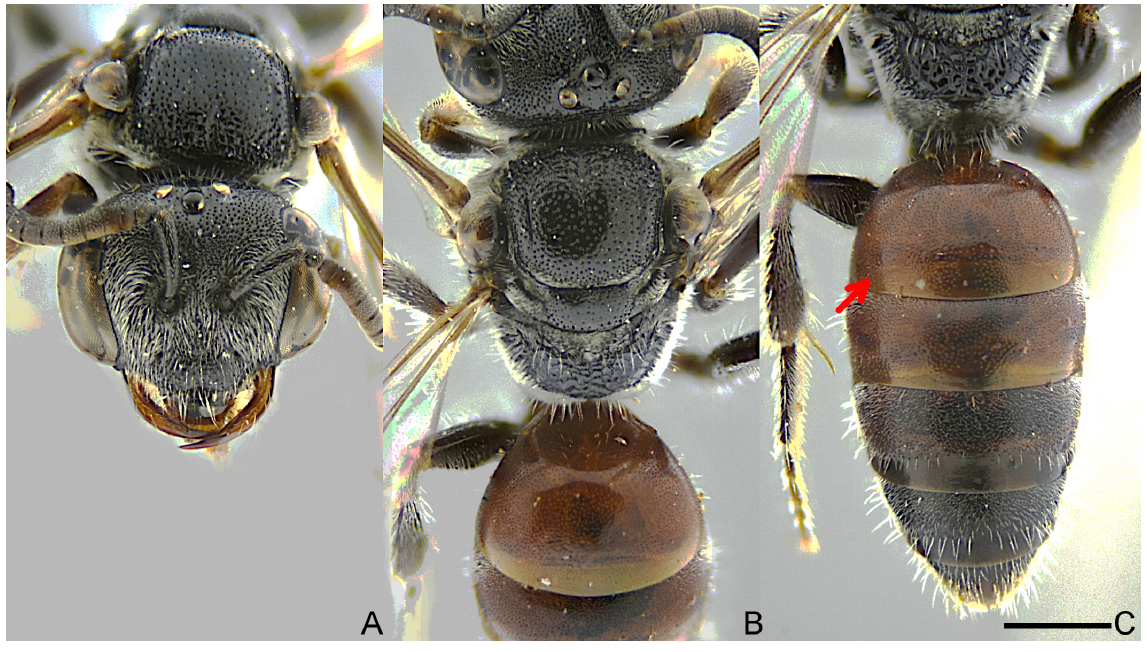
Fig. 6. Austrosphecodes krampus sp. nov., holotype, ♀ (DZUP 568515). A . Head. B . Mesosoma. C . Propodeum and metasoma, red arrow: punctate terga. Scale bar = 1